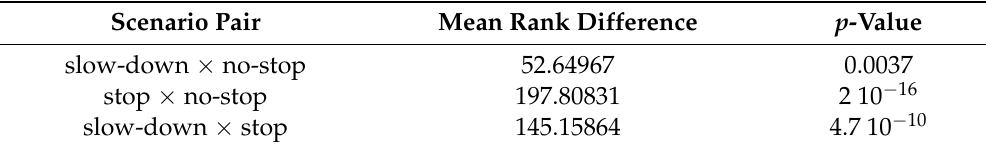
Table A2. Results of the Dunn pairwise test on the CO 2 .